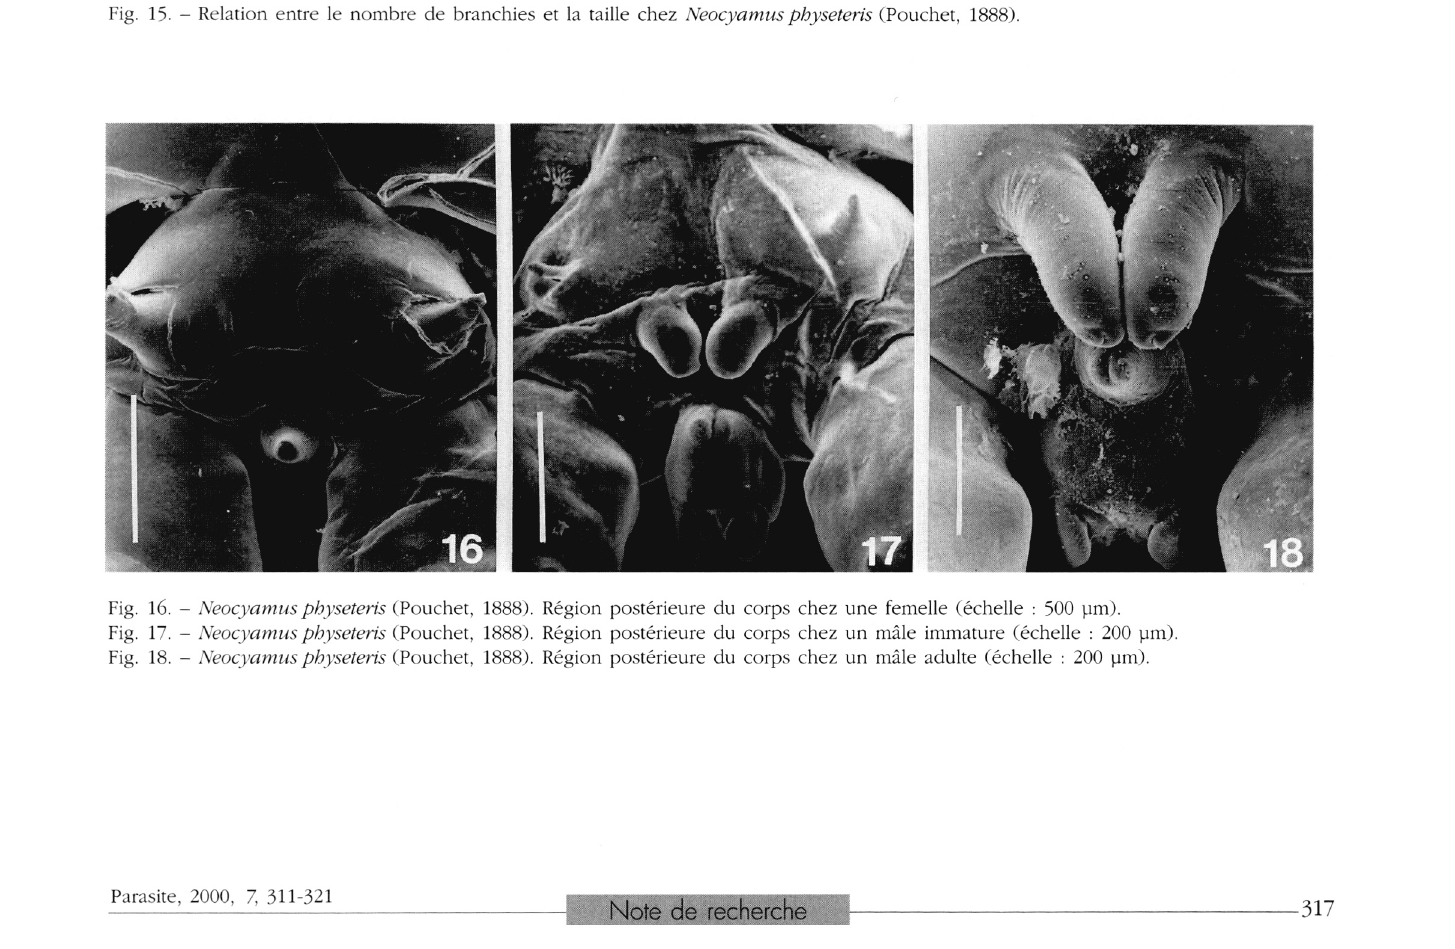
Fig. 15. - Relation entre le nombre de branchies et la taille chez Neocyamus physeteris (Pouchet, 1888).